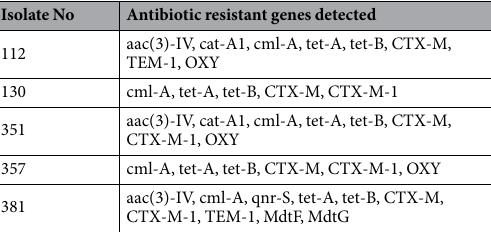
Table 2. Selected clinical isolates of poultry E. coli producing resistant genes.